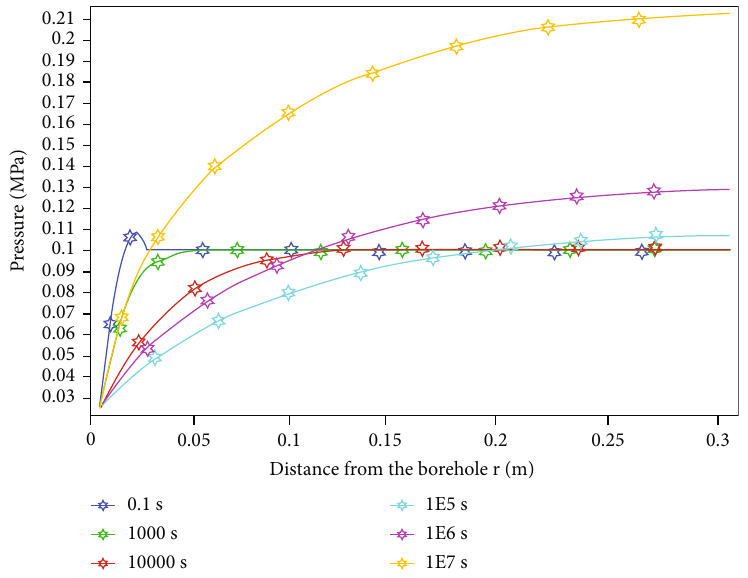
Figure 9: Pore pressure in the homogeneous coal rock during CBM